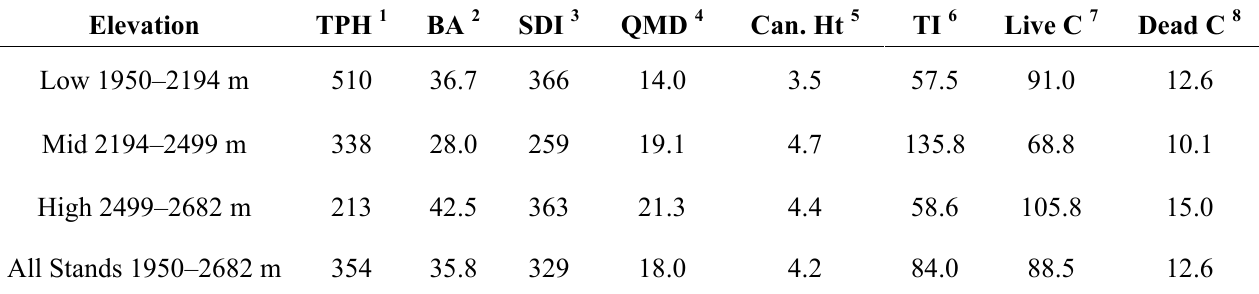
Table 1. Current stand conditions averaged from 30 stands per elevation